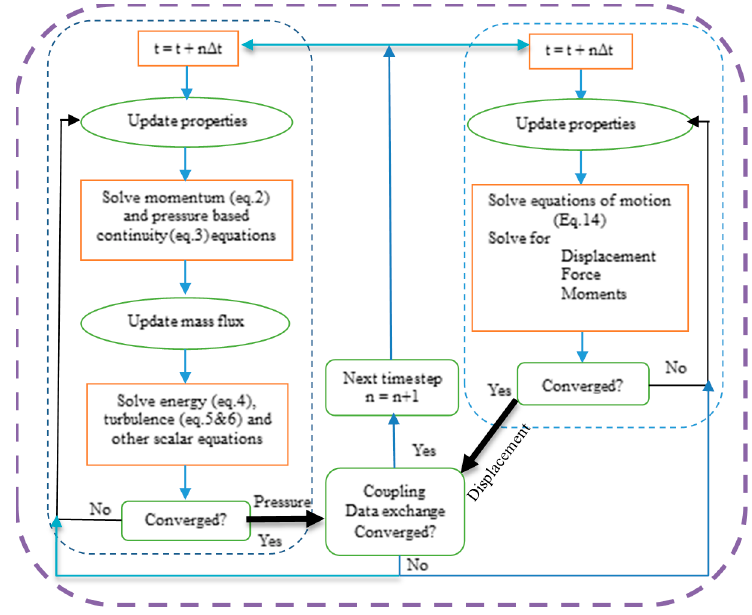
Figure 3. Bi-directional fluid structure coupling algorithm.